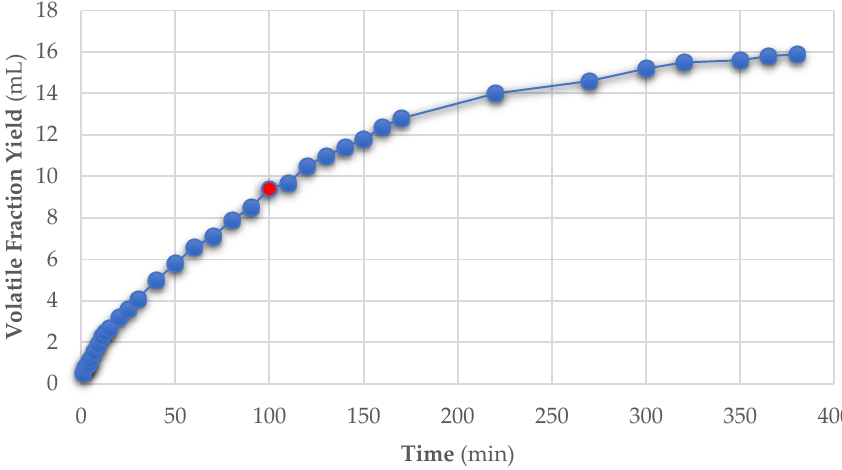
Figure 4. Extraction timeline, the red dot shows the end of the small-scale